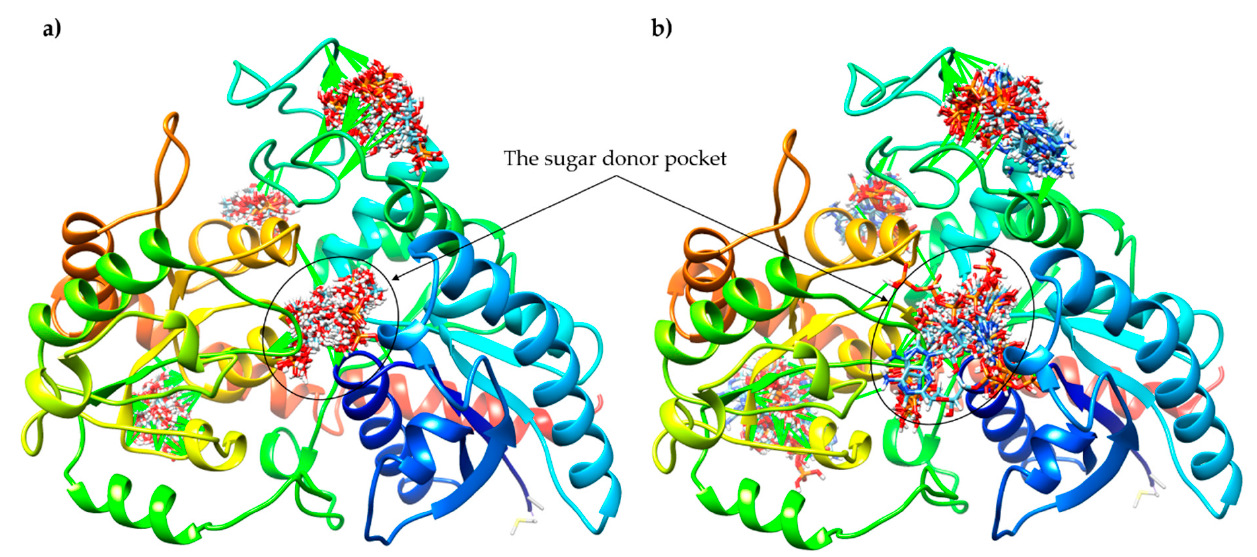
Figure 12. Results of docking of Glc-1-P ( a ) and ATP ( b ) to IAGlc synthase performed with the SwissDock server.